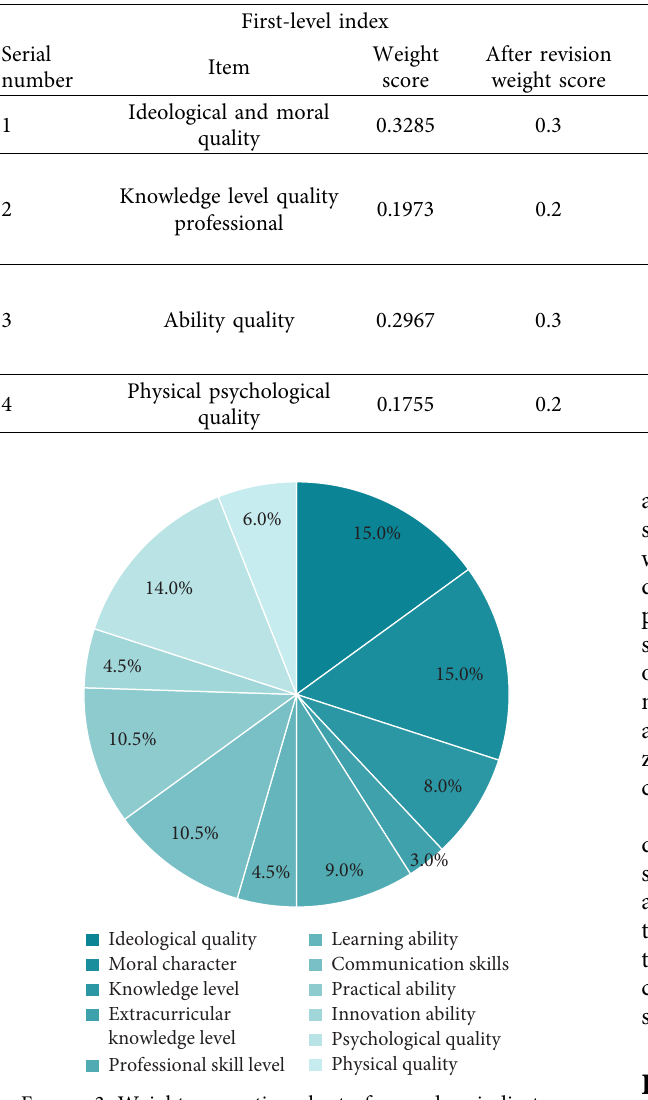
Table 16: Weight scores of indicators at all levels.